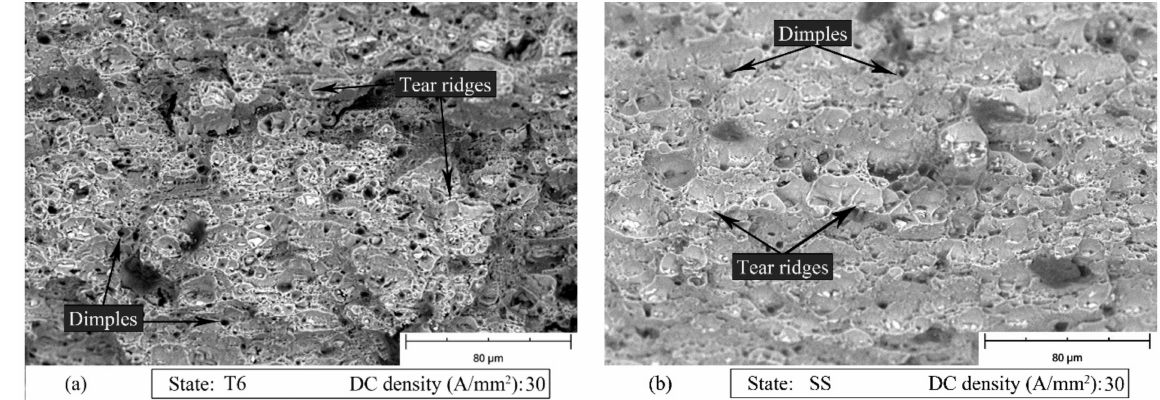
Figure 14. SEM fracture surfaces of specimen strained with 30 A/mm 2 current density application for the AA7075-T6 ( a ) and SS ( b )